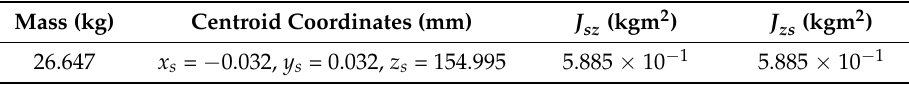
Table 6. Standard workpiece theoretical parameters in